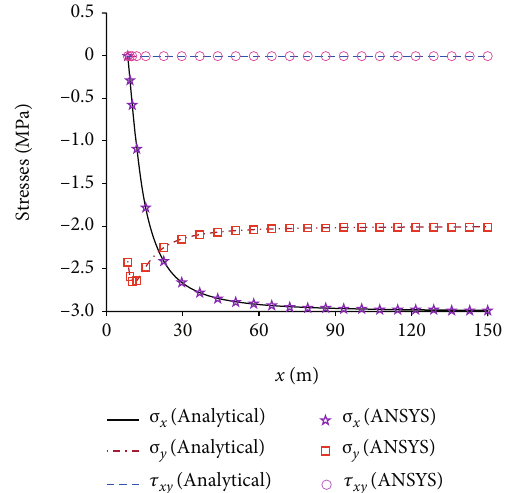
Figure 7: Distribution of stress σ θ along the tunnel boundary.